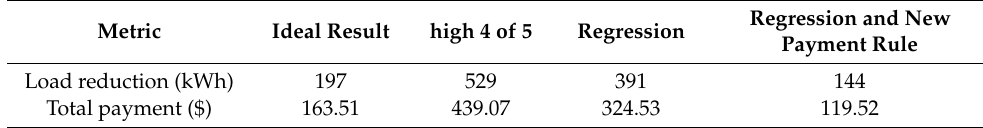
Table 6. Load reduction effect for various CBL estimation and payment methods.